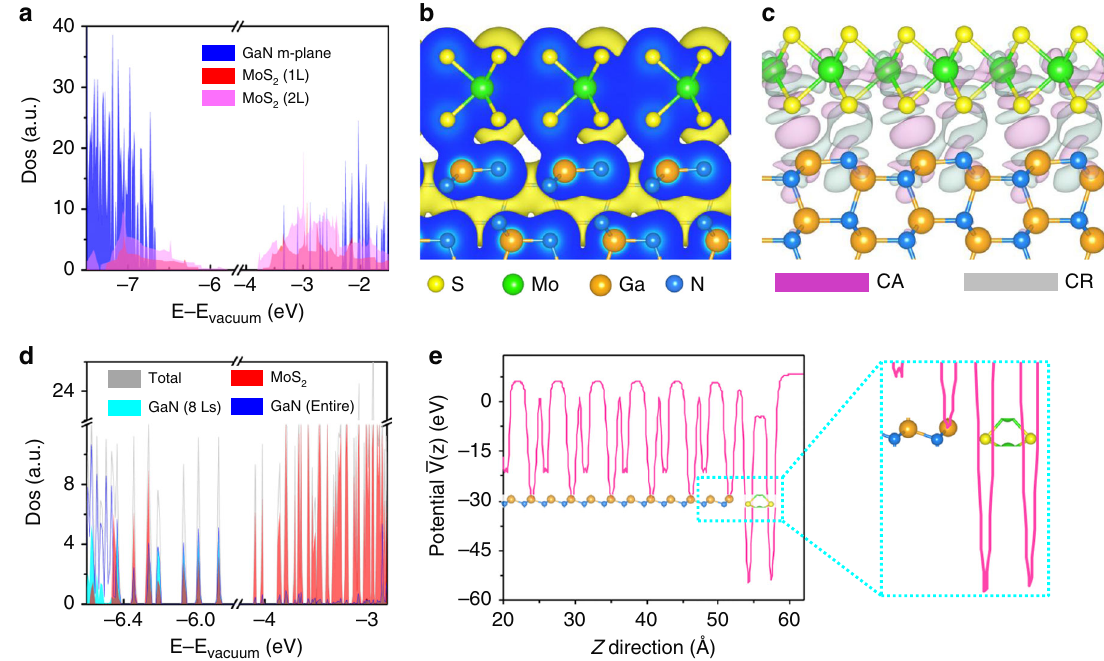
Fig. 4 Calculated electronic properties of MoS 2 /GaN(10 (cid:1) 10). a Density of states of GaN(10 (cid:1) 10), MoS 2 (1L), and MoS 2 (2L), respectively. b Charge density, c differential charge density, and d density of states of MoS 2 (1L)/GaN(10 (cid:1) 10) heterointerface. MoS 2 (1L) denotes monolayer MoS 2 . The blue part in b suggests the charge density distribution at the section. CA charge accumulation, CR charge reduction. Eight Ls in d denotes the fi rst 8 layers of GaN. e The averaged potential variation along the direction perpendicular to the MoS 2 (1L)/GaN(10 (cid:1) 10) heterointerface